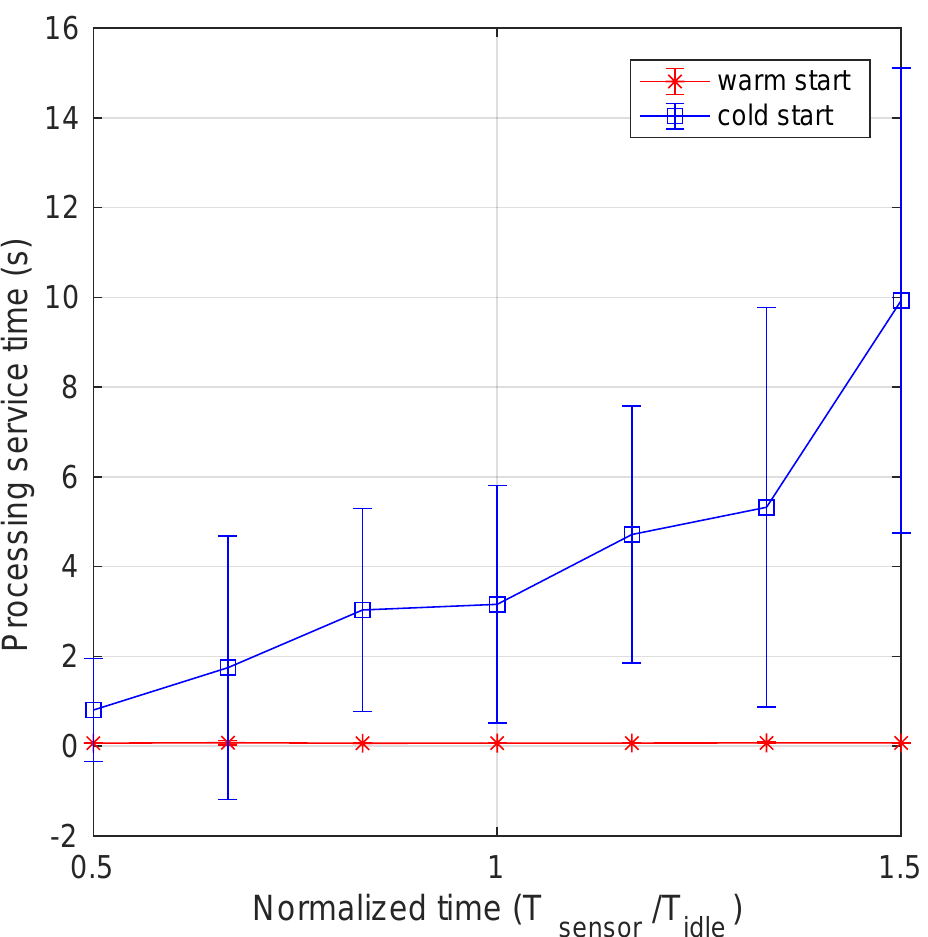
Figure 8. Processing time as a function of the normalized transmission period for both cold and warm start. The impact of pods termination and subsequent restart in cold start mode is